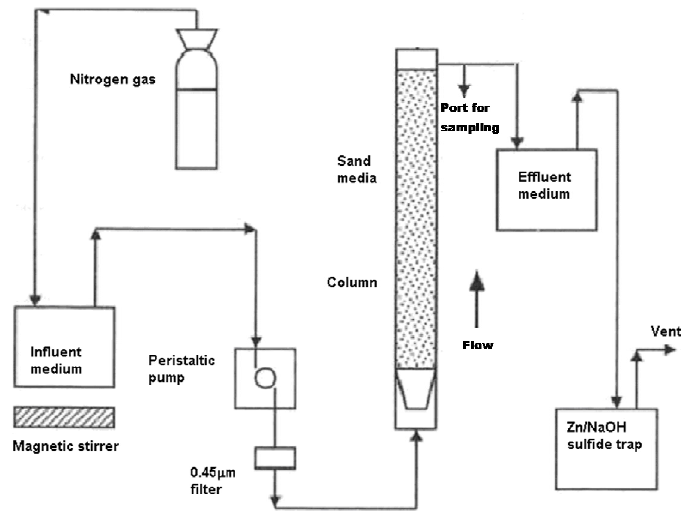
Figure 3. A schematic diagram of the up flow anaerobic packed bed reactor setup.